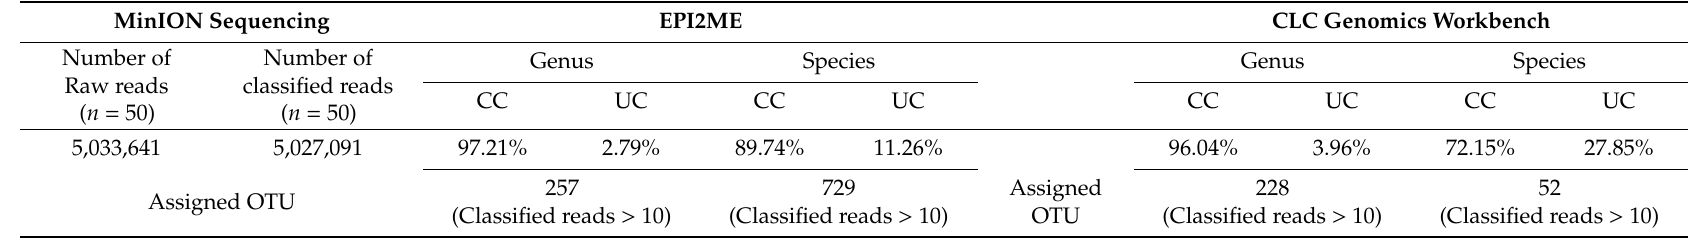
Table 2. Classification of MinION results for the taxonomic assignment with di ff erent bioinformatics workflows using the NCBI 16S or SILVA databases. The numbers of correctly classified reads at the genus and species levels are